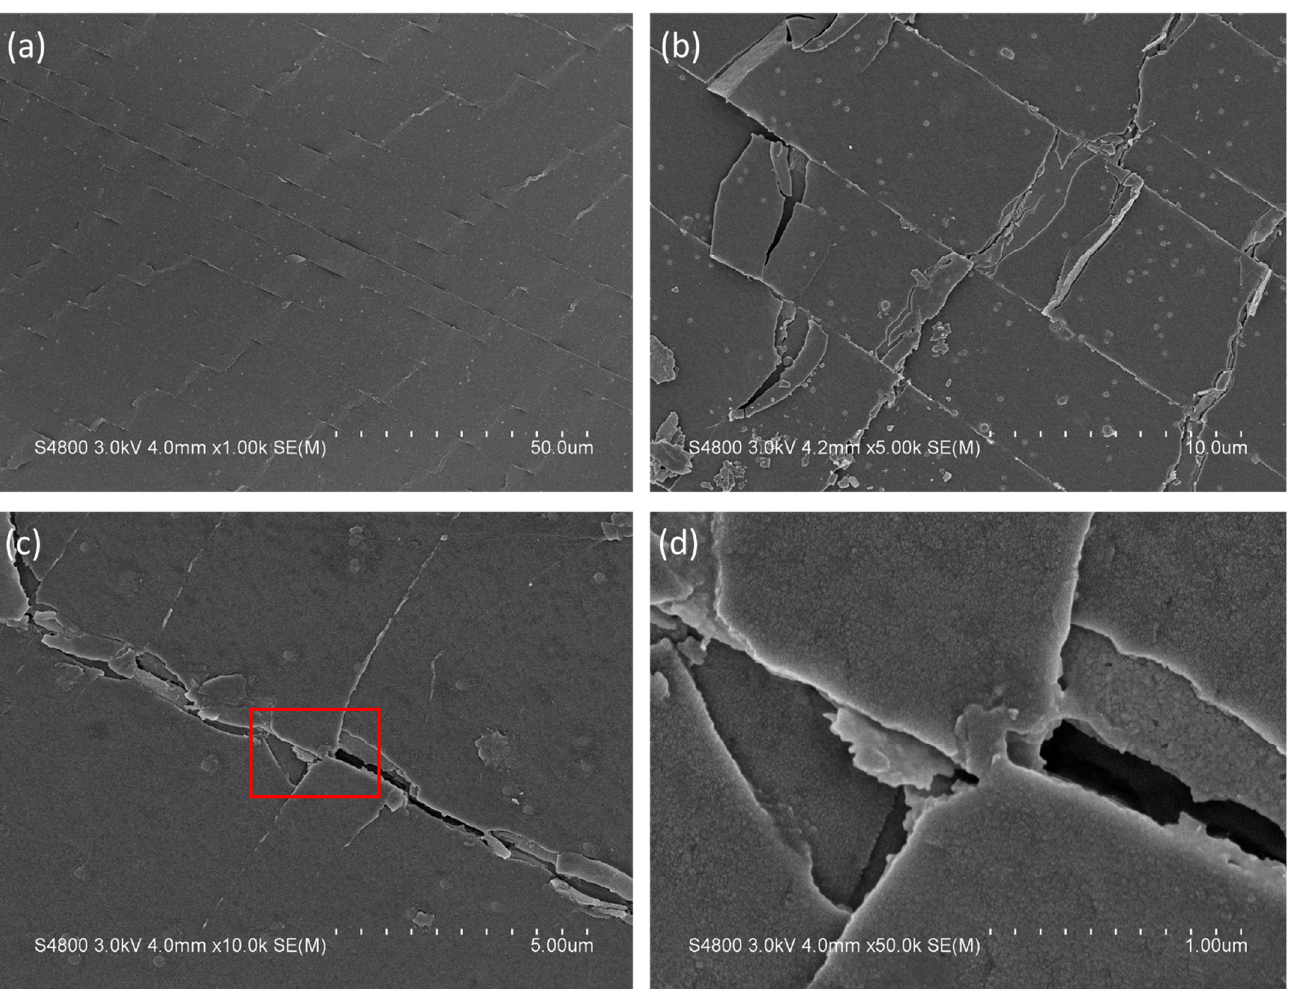
Figure 10. SEM images showing the compressive-stress-caused failure of OMO samples after cyclic bending: ( a ) low-magnification image of the 15 d aged OMO sample; ( b ) zoom-in of the red rectan- gular area in ( a ).